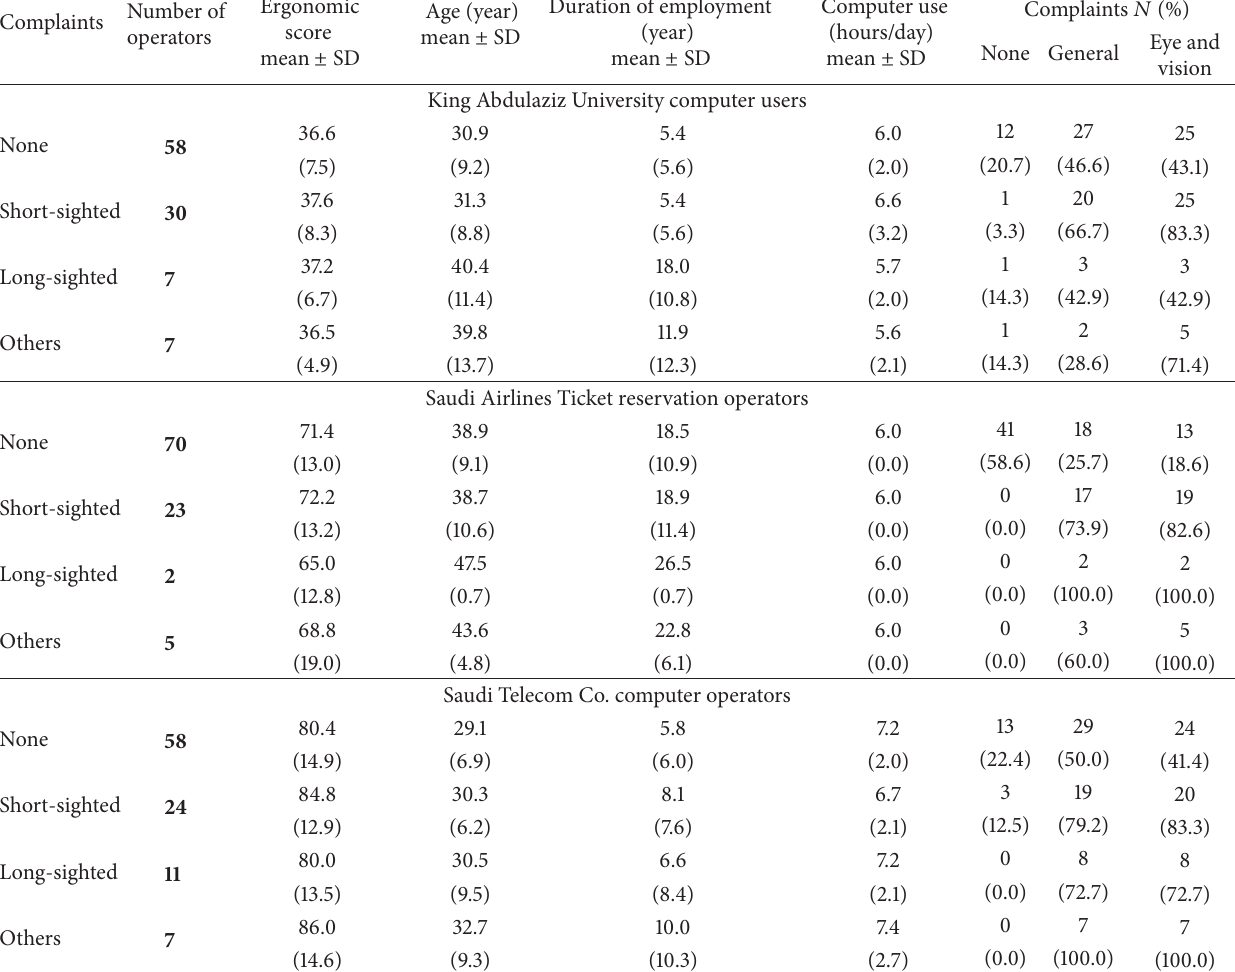
Table 16: Incidence of eye and vision complaints as related to previous ailments of computer users/operators. Number of Complaints